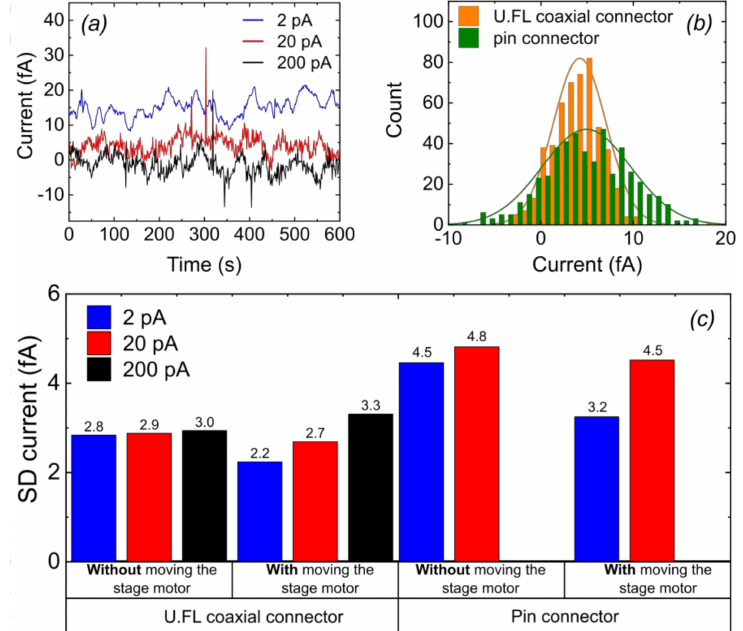
Figure 3. Internal noise of the XBIC measurement system. ( a ) The current through the nanowire device measured at 2 pA (blue trace), 20 pA (red trace) and 200 pA (black trace) current range of the amperemeter as a function of time. ( b ) The same measured current as ( a ) with a different sample holder design, that is, with U.FL connector (orange) and pin connector (green) as a terminal, plotted as a histogram exhibiting a normal distribution with fitting curve. These measurements were done at a 20 pA current range. ( c ) The standard deviation (SD) of the measured current at different measurement